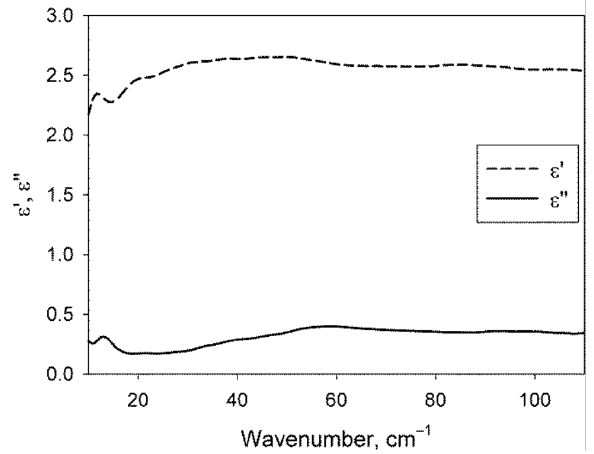
Figure 3. Real ε (cid:48) and imaginary ε ” parts of the DP of DNA contained in the studied